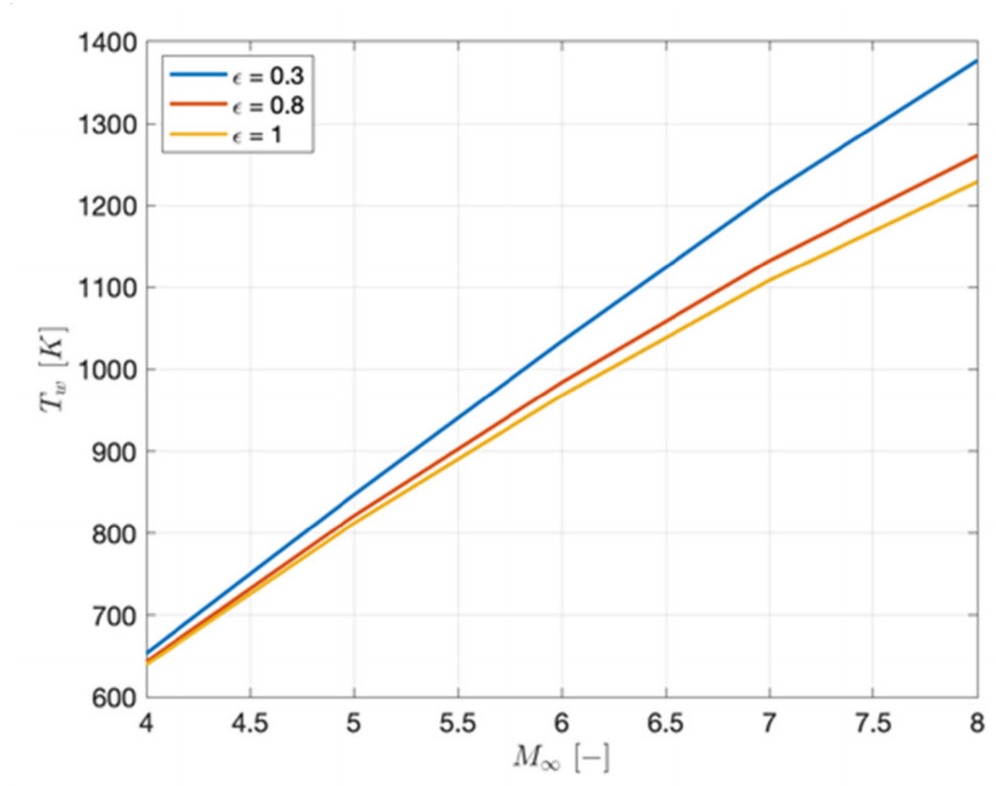
Figure 15. Wall temperature as function of the Mach number for different emissivity values. Table 4. Recovery temperature and wall temperature for different Mach numbers.